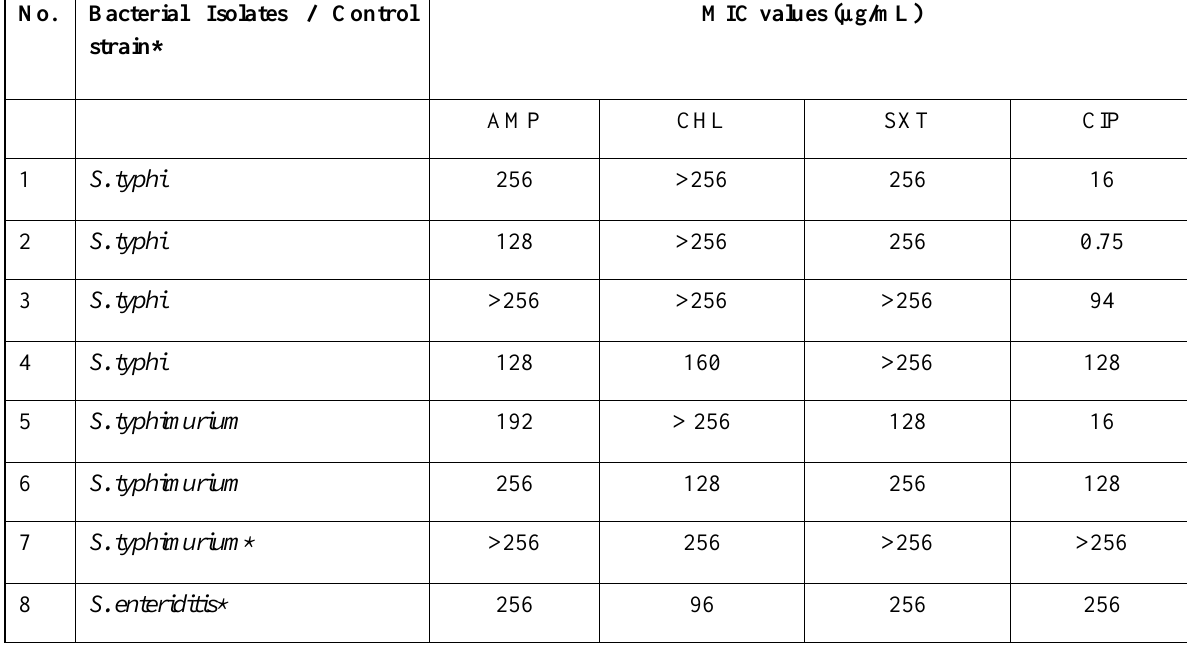
Table 3. Antibiotic susceptibility based on minimum inhibitory concentration (MIC) .